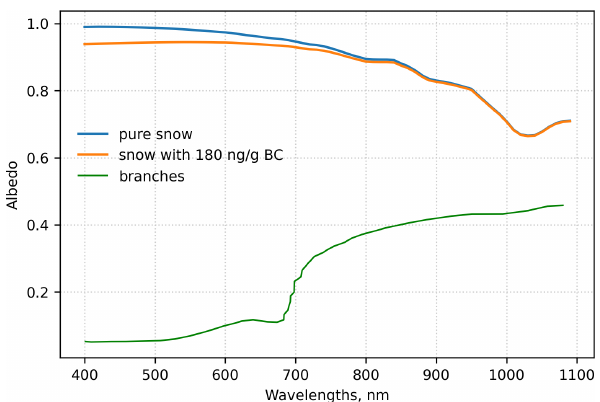
Figure 1. Comparison of the spectral albedo of pure snow (blue), dirty snow with 180ngg − 1 of BC (orange) and branches (green). Albedo of branches was determined from measurements taken by Juszak et al. (2014). Branch absorption is strongly wavelength de- pendent and decreases sharply for wavelengths >